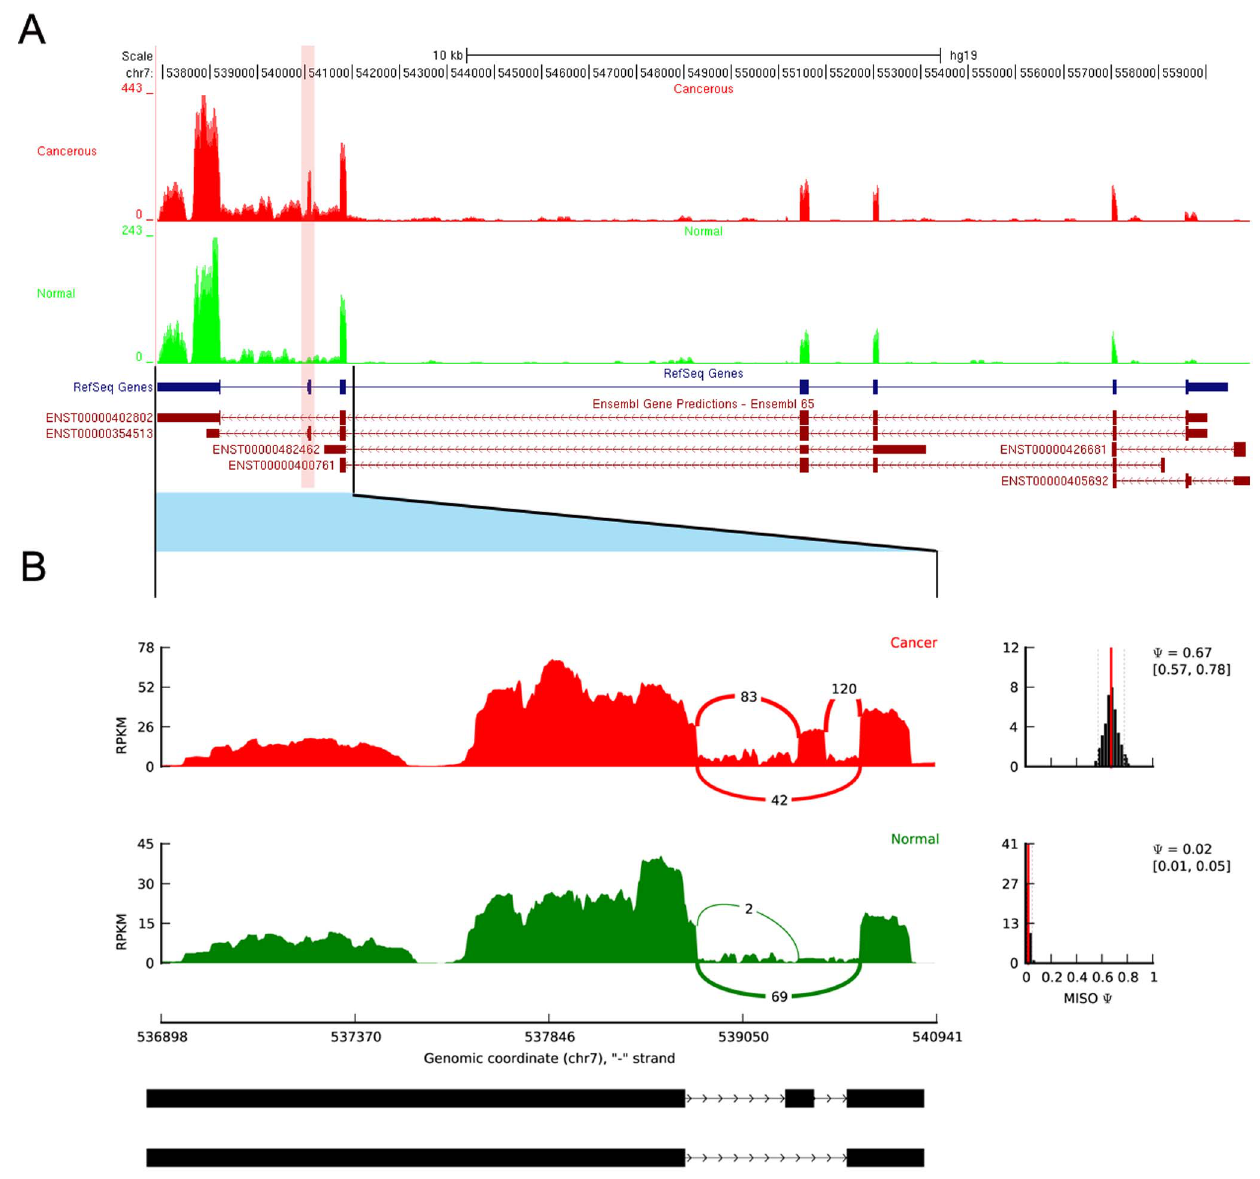
Figure 3. RNA-Seq read mapping to the reference gene PDGFA. A: RNA-Seq read mapping to the UCSC reference genome (hg19) of the gene PDGFA for UCB and non-tumor tissues in this study. The UCB tracks are shown in red and non-tumor tissue in green. The pink band indicated the location of skipped exon. B: The detail of junction reads mapping to the skipped exon and its neighboring exons. The Y (’’percentage spliced in’’) indicates the ratio of reads supporting inclusion exon vs. total reads supporting both inclusion and exclusion exon. The Y posterior distributions [25] were shown in the right side.